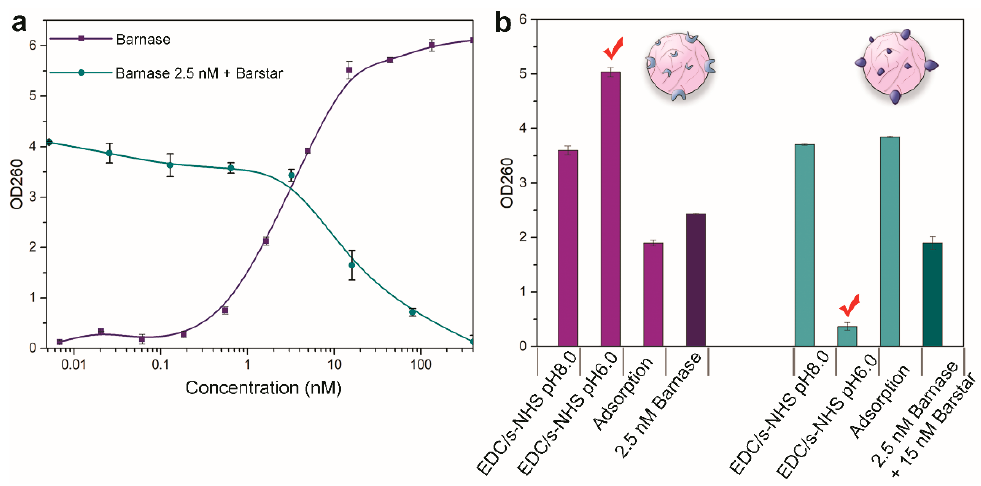
Figure 7. Functional activity of PLGA nanoparticles conjugated with barnase and barstar proteins. ( a ) The enzymatic activity of barnase (purple curve) and barstar (green curve) versus protein con- centration. Optical density at 260 nm corresponds to the concentration of free mononucleotides obtained by barnase digestion of yeast RNA (for barnase activity) and by barstar pre-incubated with 2.5 nM of barnase (for barstar inhibition activity). ( b ) The enzymatic activity of PLGA conjugates with barnase (purple bars) and barstar (green bars). Data is presented for conjugates obtained at pH 8.0, pH 6.0, and by non-covalent protein absorption on the particle surface. Optical density (OD260) corresponded to the concentration of free mononucleotides was measured at a wavelength of 260 nm. The “ √ ” symbol refers to the conjugation methods that were selected for further work.